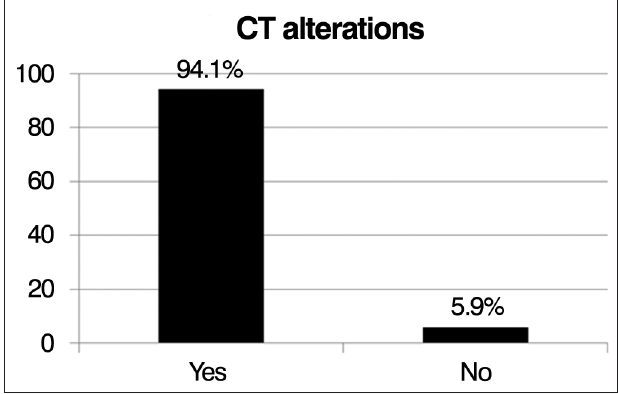
Figure 4. Frequency of changes seen upon computed tomography of the paranasal